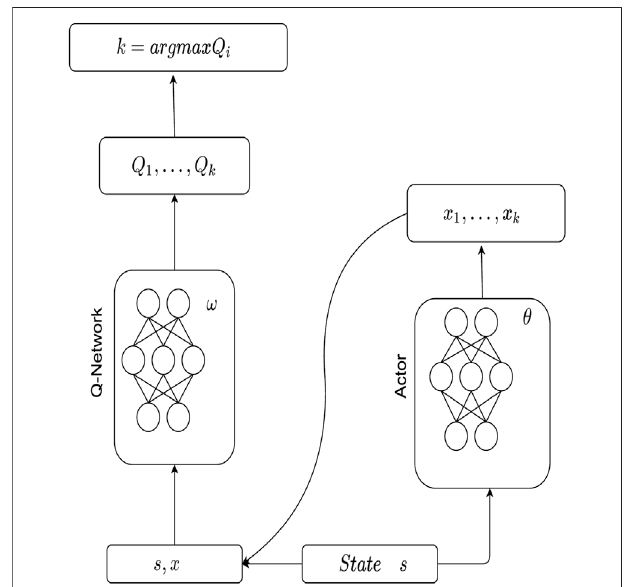
FIGURE 3 | Structure of